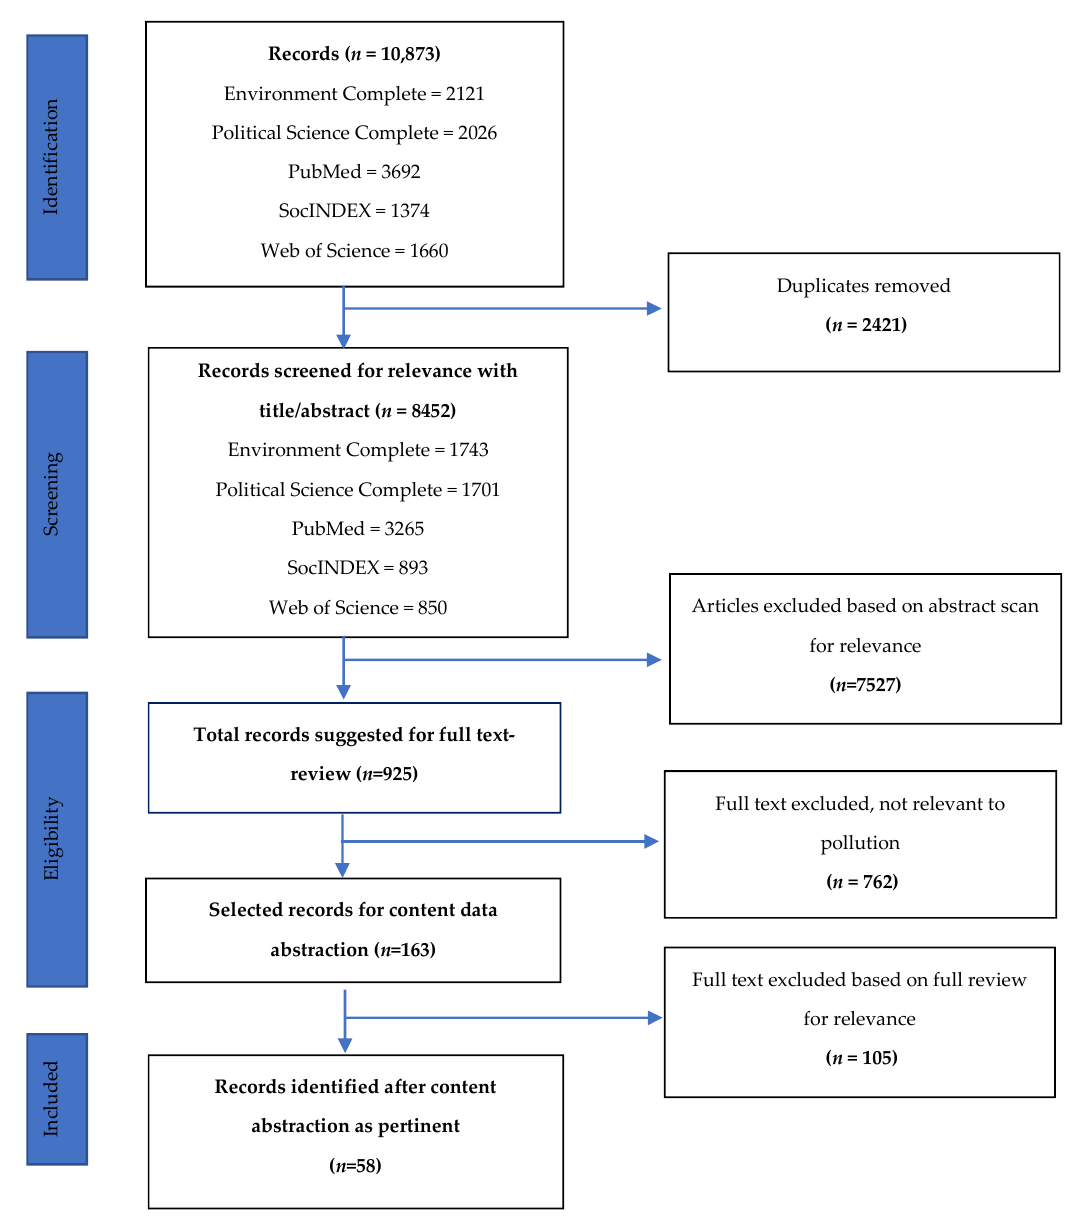
Figure 1. PRISMA (Preferred Reporting Items for Systematic Reviews and Meta-Analyses) Flow